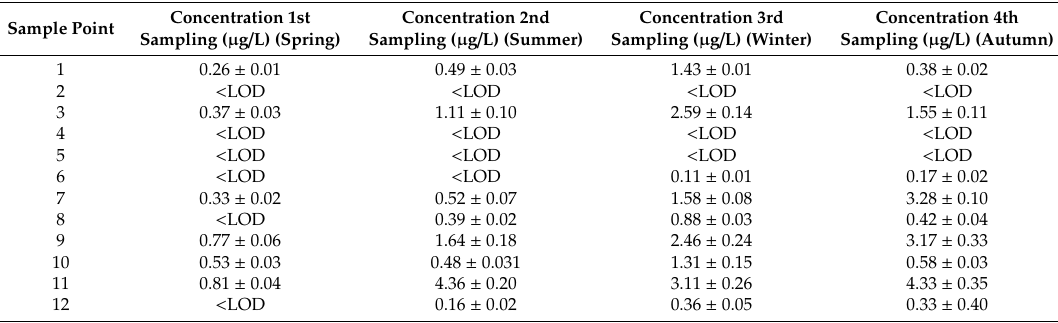
Table 3. Average glyphosate concentrations in the water samples during the four time